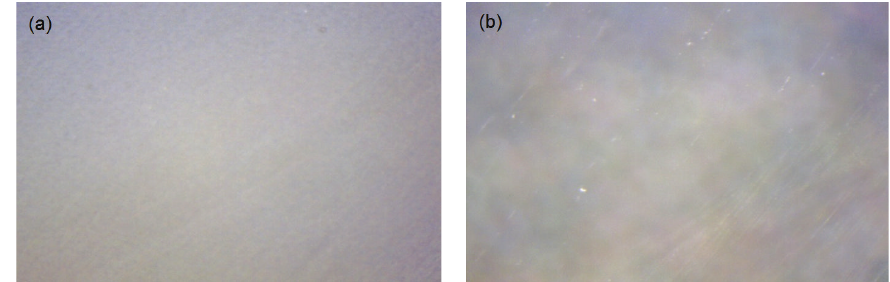
Figure 5: The 500x magnification of the coating surface of coatings from sample (a) 50N and (b) 50E.